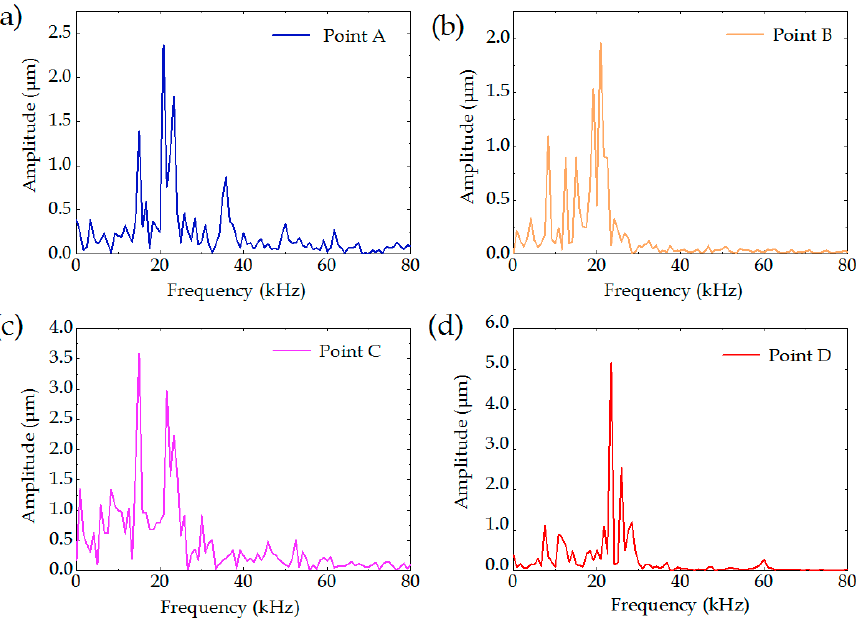
Figure 11. Amplitude–frequency diagram of vibrations on the laser machine: ( a ) amplitude–frequency diagram of point A; ( b ) amplitude–frequency diagram of point B; ( c ) amplitude–frequency diagram of point C; ( d ) amplitude–frequency diagram of point D.